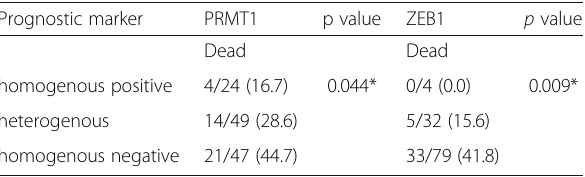
Table 9 The comparation of PRMT1 and ZEB1 expression heterogeneity and outcome of the patients with ccRCC Prognostic